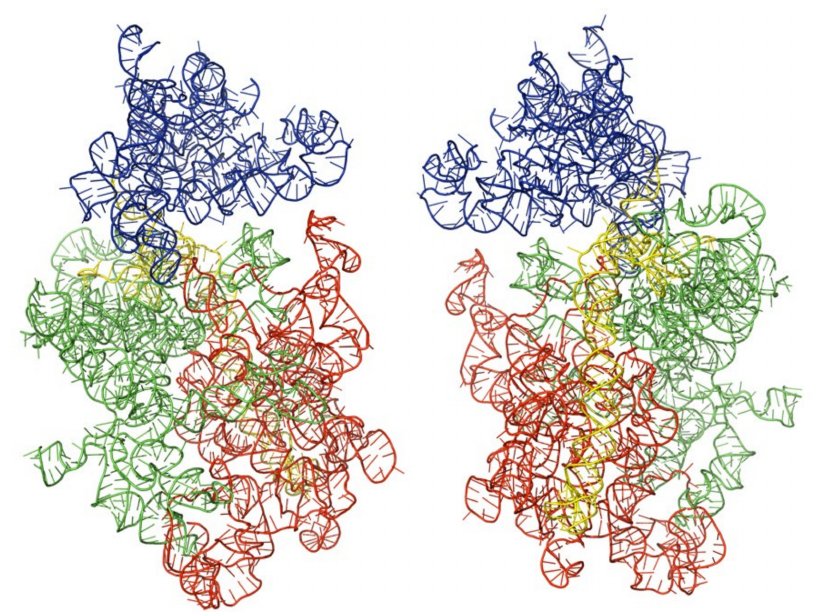
Figure 1. Architectural tertiary structure of Leishmania major 18S rRNA front and back view. Shown is the 18S rRNA, colored differently depending with domains (5 (cid:48) major—red, Central—green, 3 (cid:48) major— blue, and 3 (cid:48) minor—yellow).